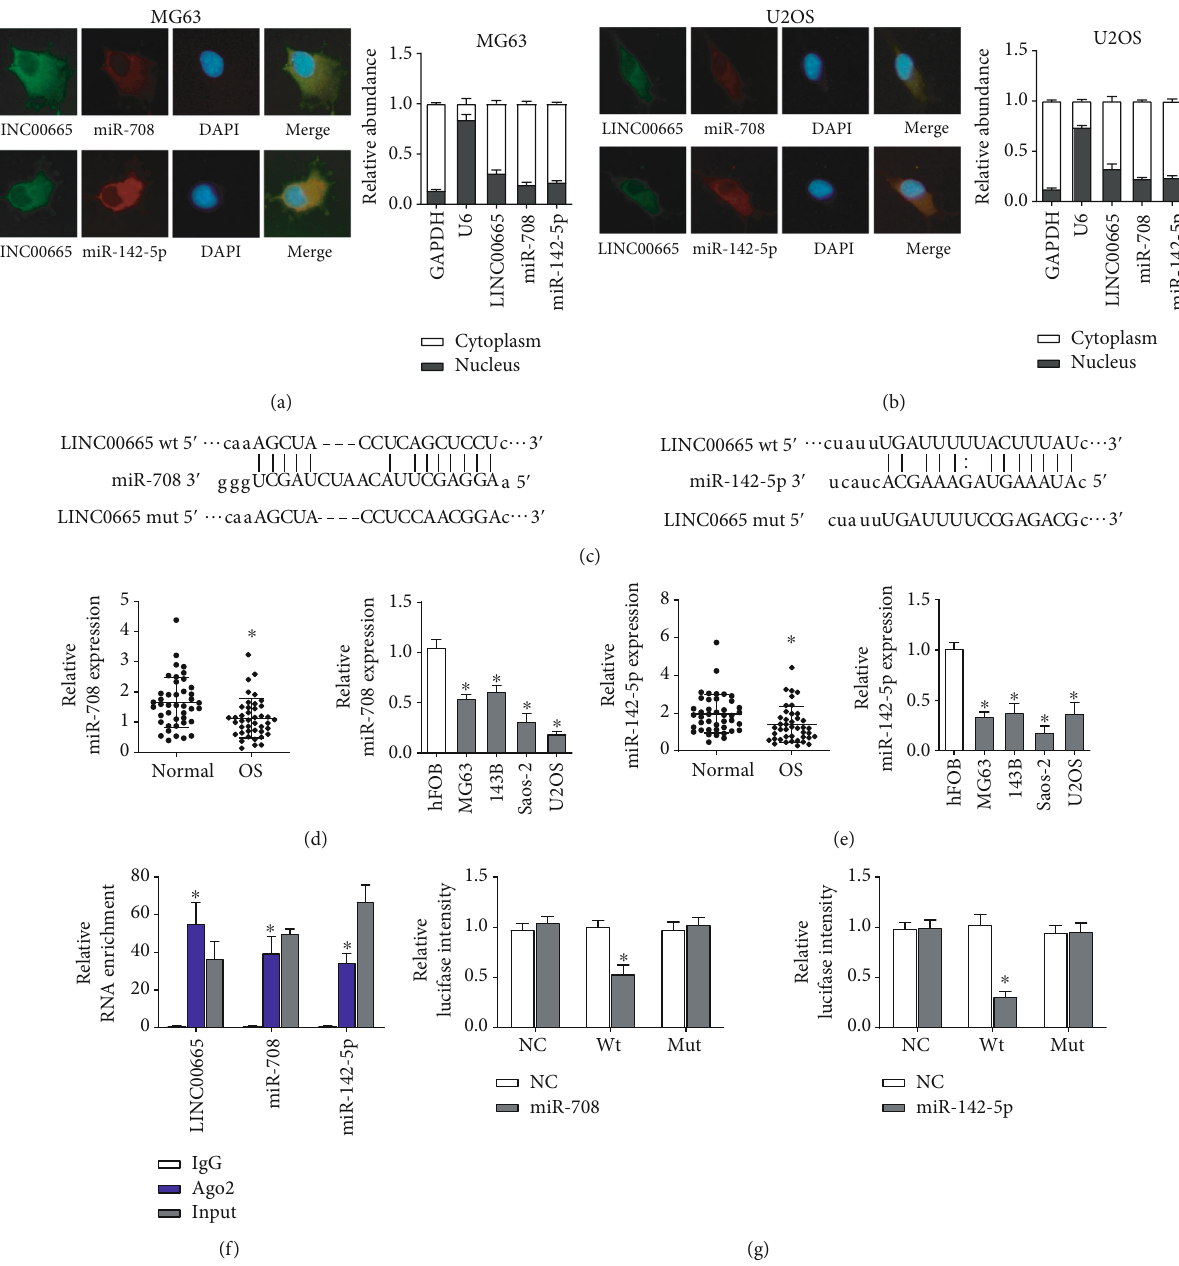
Figure 3: LINC00665 operates as a miRNA sponge for miR-708 and miR-142-5p. (a, b) FISH assays and qRT-PCR assays determined the subcellular localization of LINC00665, miR-708, and miR-142-5p in OS cells. (c) Predicted binding sequences of miR-708 or miR-142-5p with LINC00665. (d, e) Expressions of miR-708 and miR-142-5p in OS tissues and cell lines detected by qRT-PCR. (f) RIP assays identi fi ed the enrichment of LINC00665, miR-708, and miR-142-5p in Ago2 conjugates. (g) Predicted binding sequences of miR-708 or miR-142-5p with LINC00665 were validated by luciferase reporter assays. ∗ P < 0 : 05